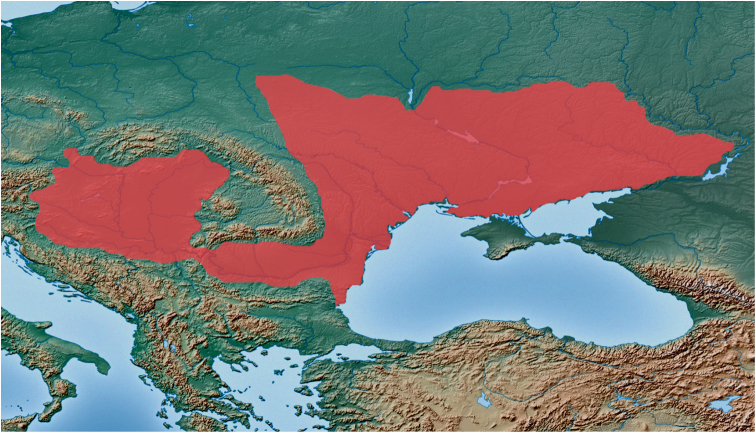
Sketch map of eastern and south-eastern part of Europe with known distribution of Lethrus (Lethrus) apterus. Compiled from the following sources: Baraud (1992) – overall range; Burakovski et al. (1983) – Poland; Endrődi (1957) – Carpathian basin; Guéourguiev and Bunalski (2004) – Bulgaria; Horion (1958) – Austria; Juřena et al. (2008) – Czech Republic, Slovakia; Mikšić (1970) – Serbia; Nikolajev (2003) – overall range; Panin (1957) – Romania; Semenov-Tian-Shanskij and Medvedev (1936) – overall range. Base map source: http://www.naturalearthdata.com/downloads/10m-raster-data/.